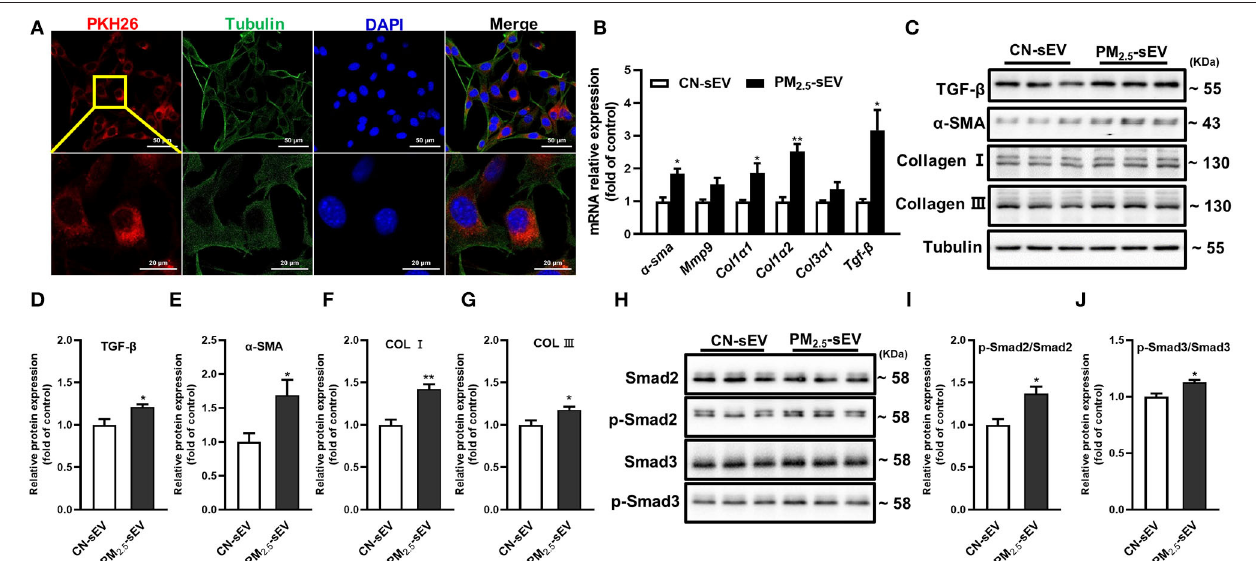
FIGURE 6 | TGF- β -containing sEV-induced production of collagen through TGF- β -Smad2/3 signaling pathway in cardiomyocytes. (A) Representative images of HL-1 cells that were incubated with the RAW264.7-sEV of PKH26-labeled sEV (red), cytoskeleton was stained with tubulin (green) and nuclei with DAPI (blue). Scale bar: 50 µ m, 20 µ m. (B) Relative mRNA expressions of α -SMA, mmp9, Col1 α 1, Col1 α 2, Col3 α 1, and TGF- β in HL-1 after being treated with RAW264.7-sEV analyzed by qRT-PCR. (C–G) Relative protein expressions of GF- β , α -SMA, Col I, and Col III in HL-1 were analyzed by Western blot. (H–J) Quantification of